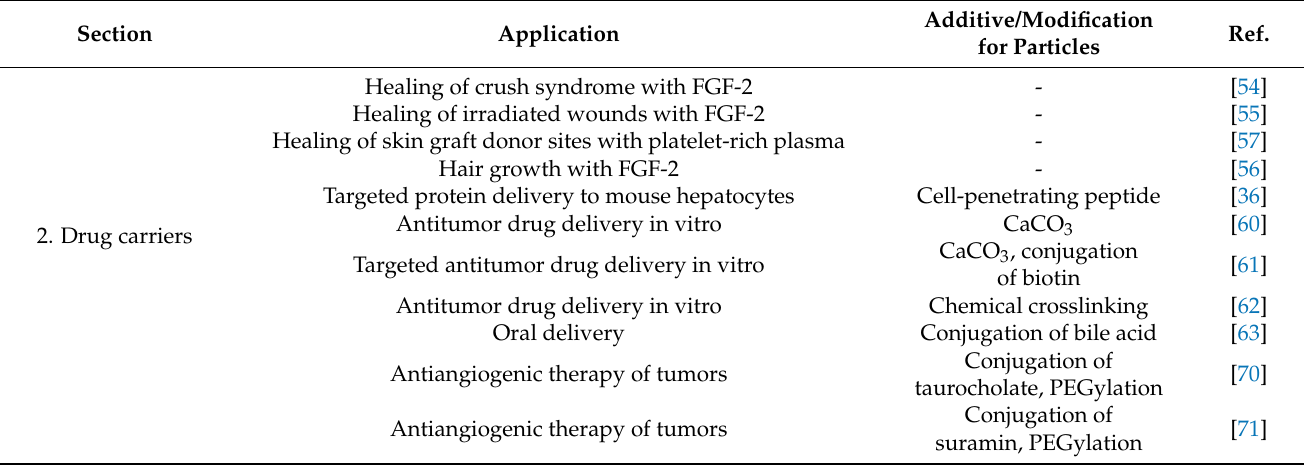
Table 1. Recent studies on the biomedical application of heparin–protamine